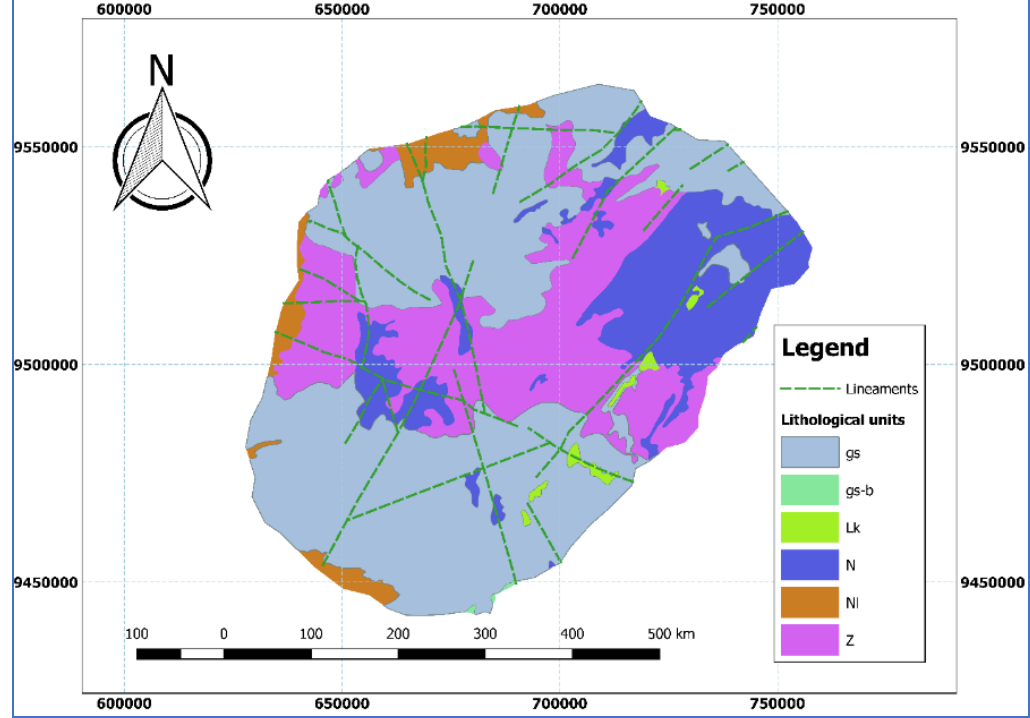
Figure 2. The geology of the Singida aquifer and the lineament system distribution.